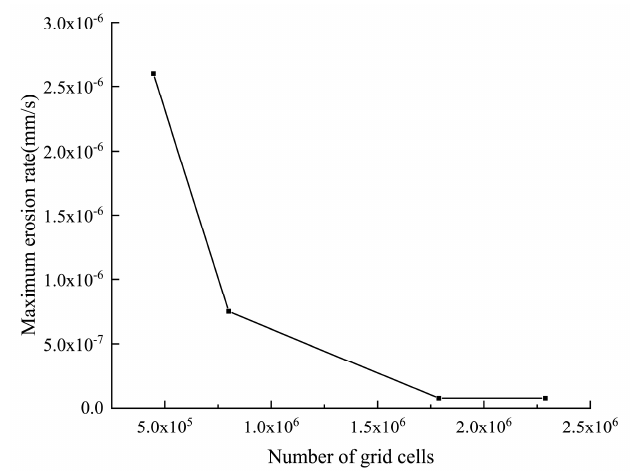
Figure 2. Grid-independence verification.